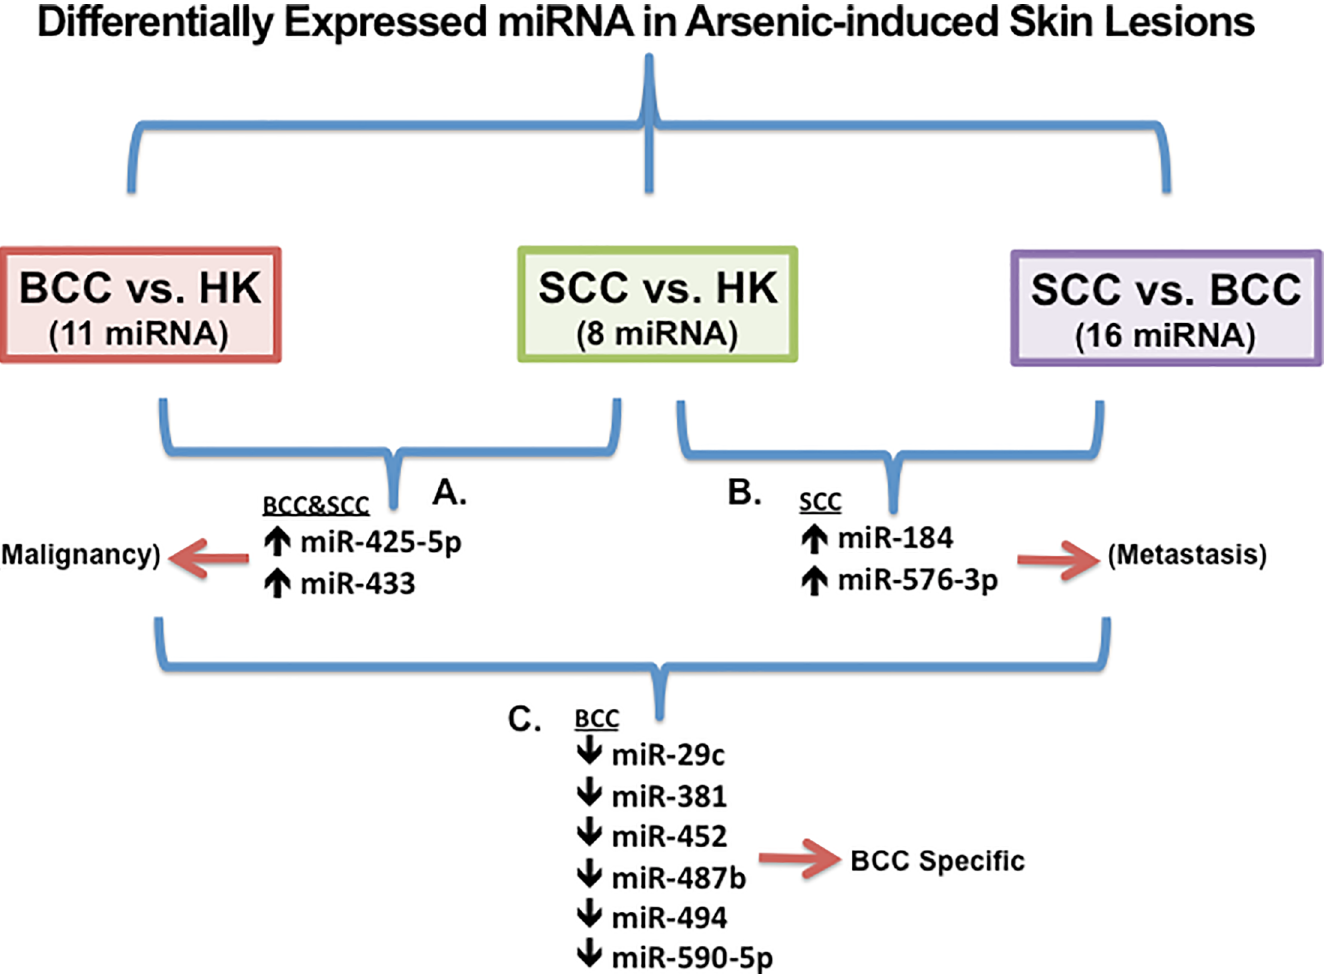
Fig 3. Differentially expressed miRNA in arsenic-induced skin lesions. Differential expression comparisons are diagrammed. Differentially expressed miRNAs in: A . malignant lesions, both BCC and SCC relative to HK; B . Specific to SCC vs HK or BCC; C. Specific to BCC vs SCC or HK. Direction of expression changes indicated by arrows. Additional differentially expressed miRNAs are listed in S1